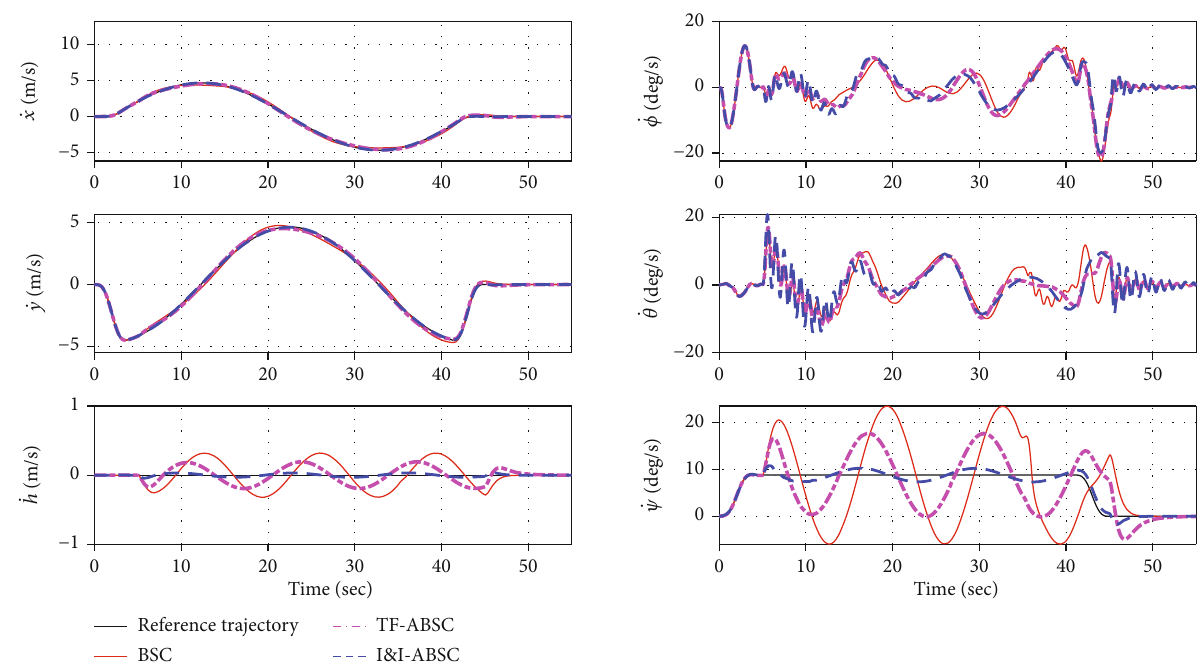
Figure 5: Case A: velocity tracking results of BSC, TF-ABSC, and I&I-ABSC.